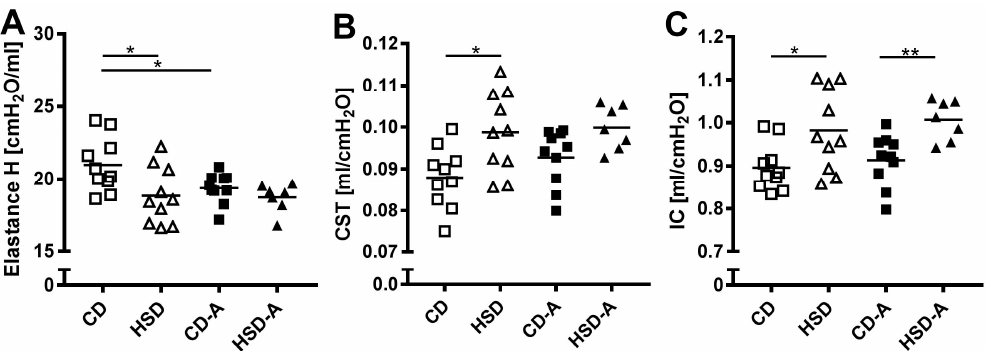
Figure 1. Effects of high sucrose intake and voluntary activity on lung mechanics. Mice were fed a control diet (CD) or a high sucrose diet (HSD) and were left untreated or had access to running wheels (CD-A, HSD-A). Lung mechanics measurements were performed after 30 weeks. ( A ) Elastance H, ( B ) Static lung compliance, ( C ) Inspiratory capacity. Values are individual data points, with means indicated by horizontal lines. Data were compared by 2-Way ANOVA followed by Tukey test; p -values < 0.05 are indicated: * p < 0.05, ** p < 0.01.